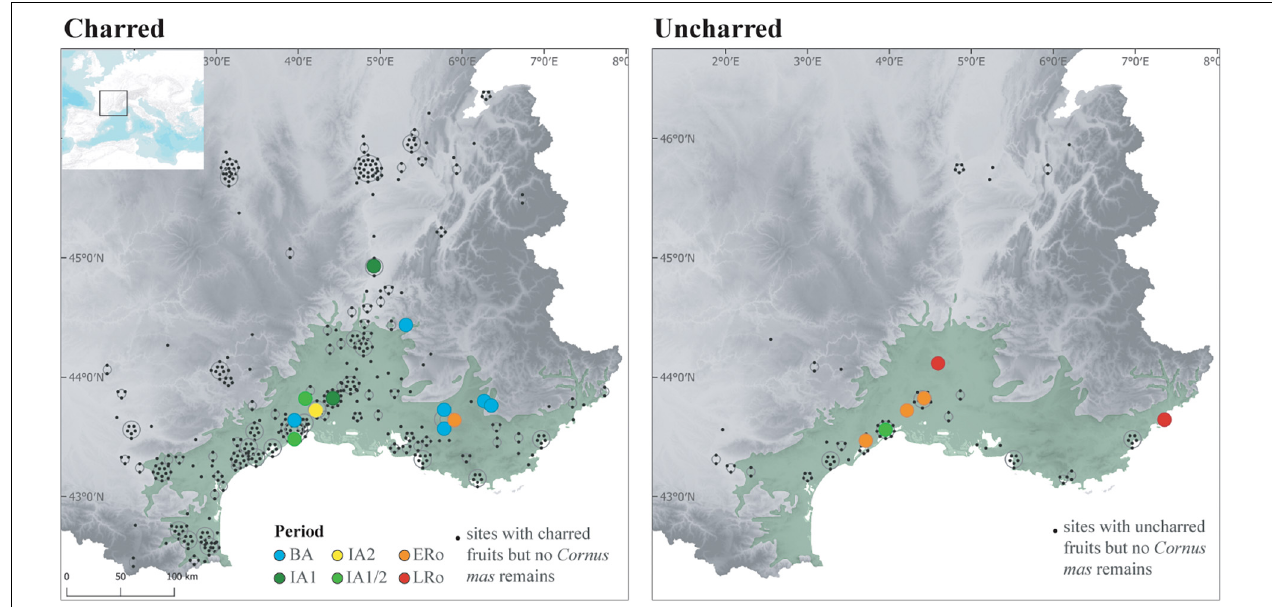
FIGURE 11 | Maps showing the distribution of the records of cornelian cherry ( Cornus mas ) in the sites according to archeological periods and preservation